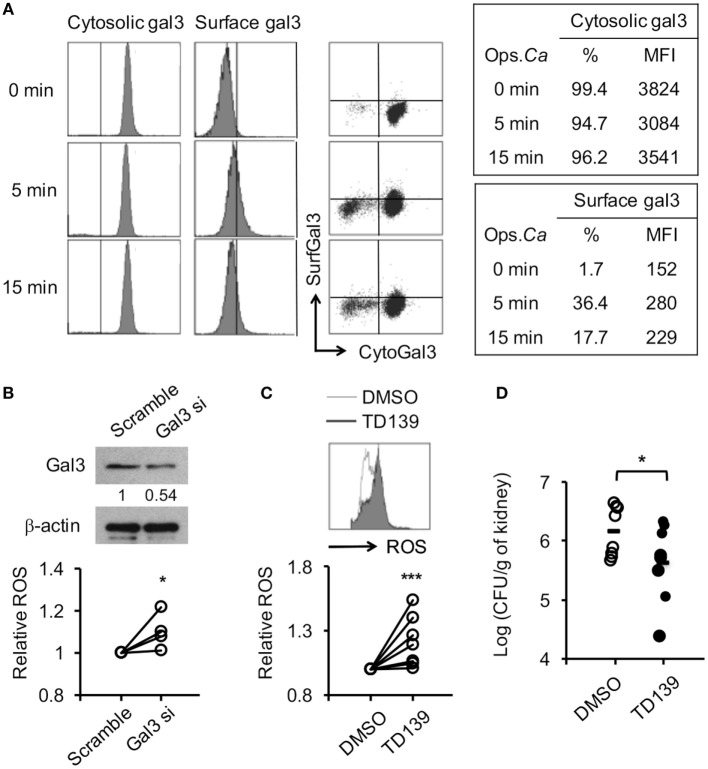
Reducing gal3 expression or activity enhances human neutrophil reactive oxygen species (ROS) response to opsonized Candida and host resistance to Candida infection. (A–C) Human neutrophils isolated from peripheral blood of healthy volunteers were allowed to ingest opsonized (in 5% human serum) Candida yeasts. (A) The % of cells expressing cytosolic gal3+ or surface gal3+ in total cells. (B,C) Cells were transfected with gal3 (Gal3 si) or scrambled (Scramble) siRNA (B) or pretreated with mock (0.5% DMSO) or 250 µM of TD139 for 4 h (C) before stimulation with opsonized Candida. The level of ROS production by neutrophils was analyzed by flow cytometry at 20 min after stimulation. Relative ROS production was calculated by dividing the mean fluorescence intensity (MFI) of cells treated with Gal3 siRNA TD139 and by that treated with scrambled siRNA and in DMSO, respectively. The levels of gal3 protein in cells transfected with gal3 or scrambled siRNA were detected by Western blot to determine the efficiency of gal3 siRNA knockdown. β-actin was used as a loading control. The numbers below the gel denote the relative intensity of gal3. (D)
Gal3+/+ mice were infected with 5 × 105 of Candida yeast cells intravenously. After 30 min, infected mice were injected with 1.5% DMSO (DMSO) or 300 µg of TD139 in 200 µl of RPMI medium intraperitoneally. Fungal burdens in kidneys from infected mice on 2 days after infection are shown as Log10 (CFU per gram of kidney) n = 4 in panel (B); n = 7 in panel (C); and n = 8 in panel (D). *p < 0.05; ***p < 0.005, as analyzed by Mann–Whitney test.